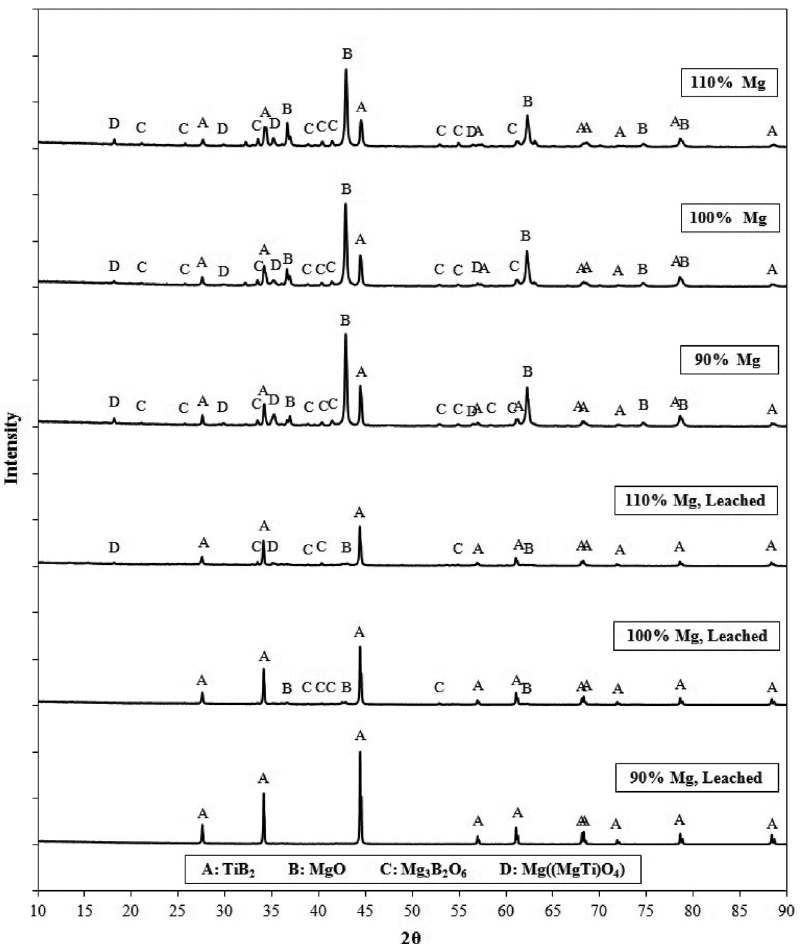
Fig. 2: XRD patterns of unleached and leached SHS products synthesized under atmospheric